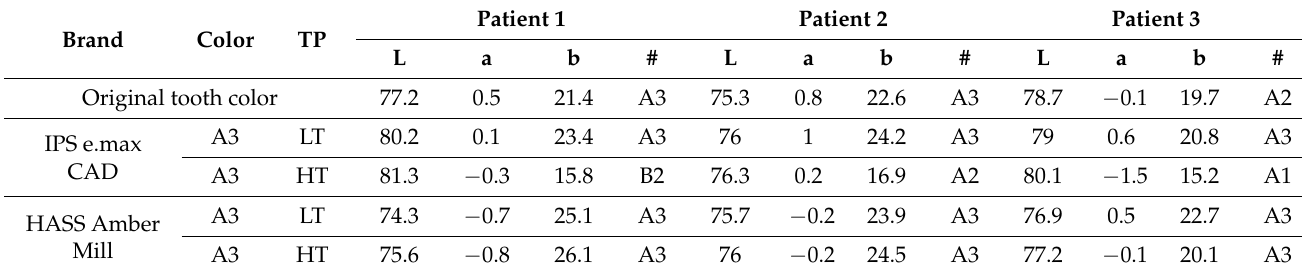
Figure 11. Optical images of A3 color glass-ceramics placed in the human oral cavity.